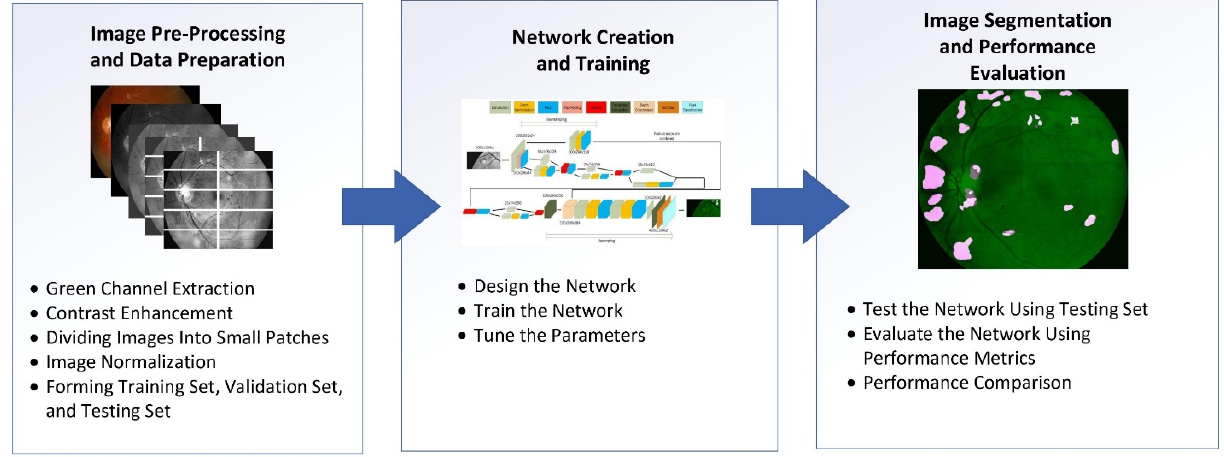
Figure 1. Flow chart of the methodology.